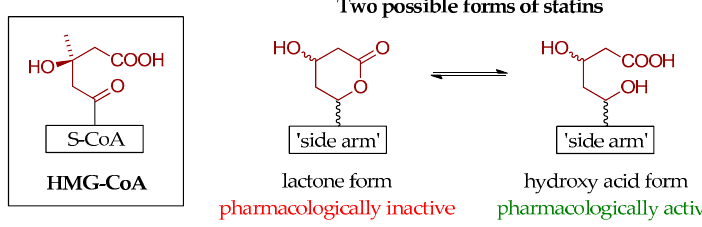
Figure 2. The similarity between structures of HMG-CoA molecule and statins.